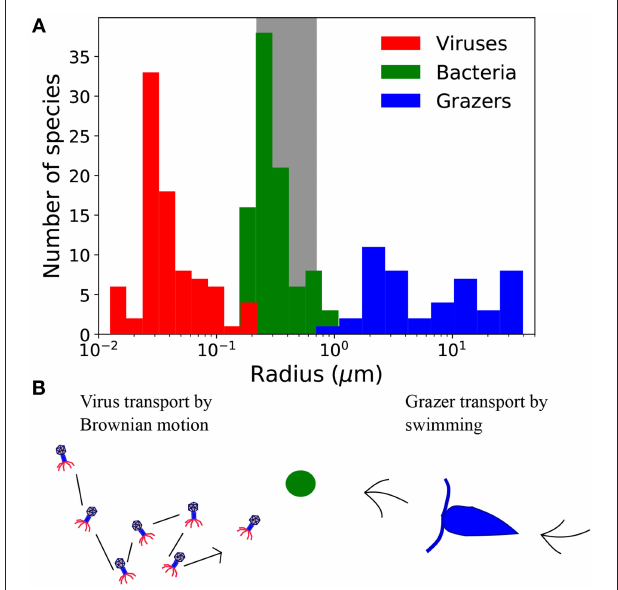
FIGURE 1 | (A) Size distribution of virus, bacteria, and grazers. Virus radius relates to capsid cross-section, and bacteria and grazer values are equivalent spherical radius. Viruses include a compilation of bacteriophage (Brum et al., 2013; Jover et al., 2014) and viruses of eukaryotic algae (Brussaard, 2004; Brum et al., 2013 ), including the largest, “giant viruses” (Abergel et al., 2015). Bacteria are from the compilation of DeLong et al. (2010), and include a range of marine and non-marine species. Grazers are from Taniguchi et al. (2014). Frequency at each size represents the number of cultured strains, which says nothing of the relative abundance at each size, or phylogenetic contrast (Felsenstein, 2017). (B) Contrasting strategies to encounter prey, represented here with the green circle. Viruses are dependent on Brownian motion, whereas grazers must swim to find